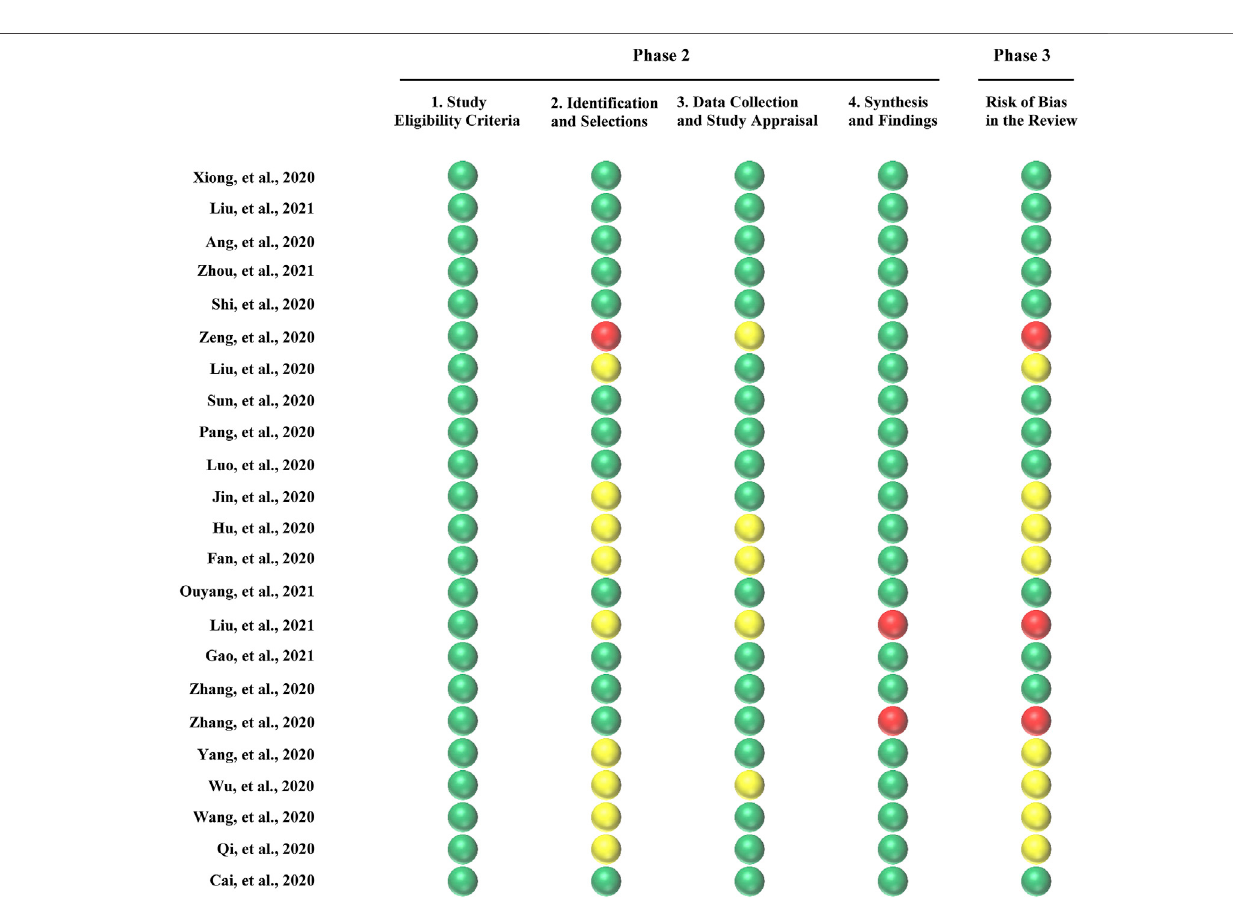
Frontiers in Pharmacology | www.frontiersin.org February 2022 | Volume 12 | Article 807491